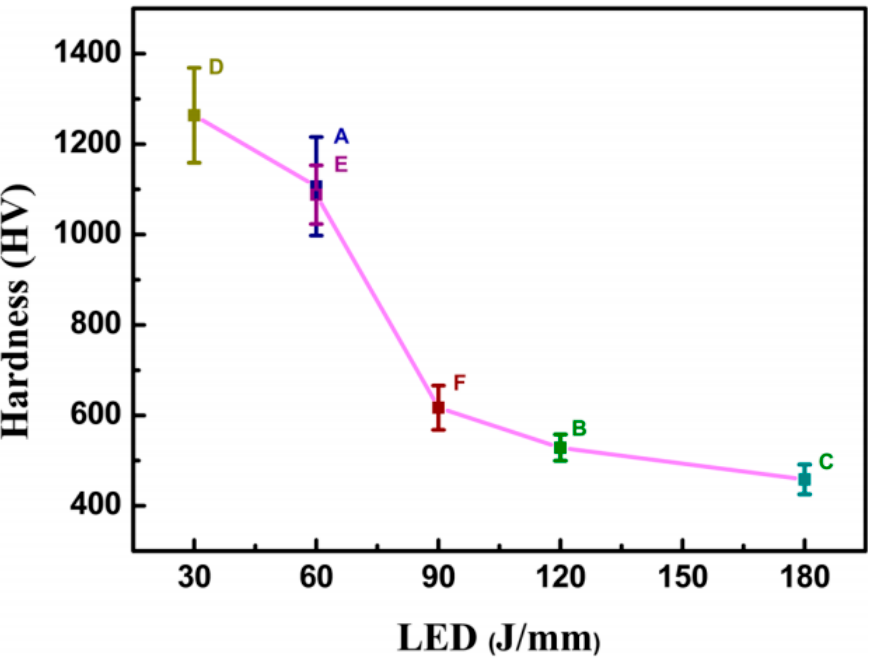
Figure 19. Hardness of the LENS-processed Fe 41 Co 7 Cr 15 Mo 14 C 15 B 6 Y 2 amorphous alloys as a func- tion of laser energy density (LED) (A, B, C, D, E and F denote Fe 41 Co 7 Cr 15 Mo 14 C 15 B 6 Y 2 samples that were produced using different laser parameters, i.e., laser energy density (LED). A and E have the same LED; however, for A, p = 300 W and v = 5 mm/s and for E, p = 600 W and v = 10 mm/s, for B: p = 600 W and v = 5 mm/s, for C: p = 900 W and v = 5 mm/s, for D: p = 300 W and v = 10 mm/s and for F: p = 900 W and v = 10 mm/s) (reprinted with the permission from [91], Springer, 2019).